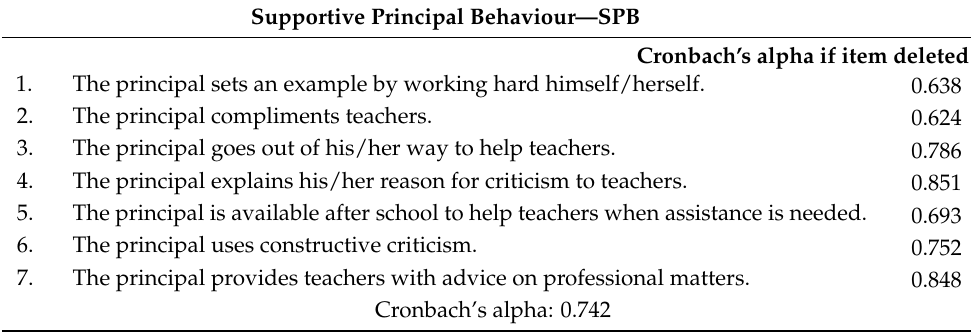
Table 3. Supportive principal behaviour SPB—Cronbach’s alpha for internal consistency.